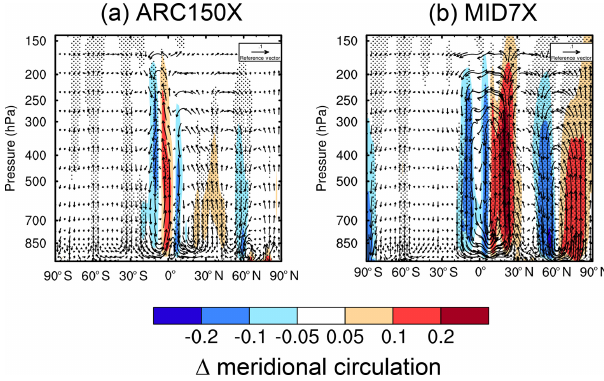
Figure 5. Changes in annual and zonal-mean meridional wind vec- tors (m s − 1 ) and vertical velocity (contours; Pas − 1 scaled by a fac- tor of − 100) for ARC150X (a) and MID7X (b) compared to PD. The dotted areas indicate statistical significance with 95% confi- dence from a two-tailed Student’s t